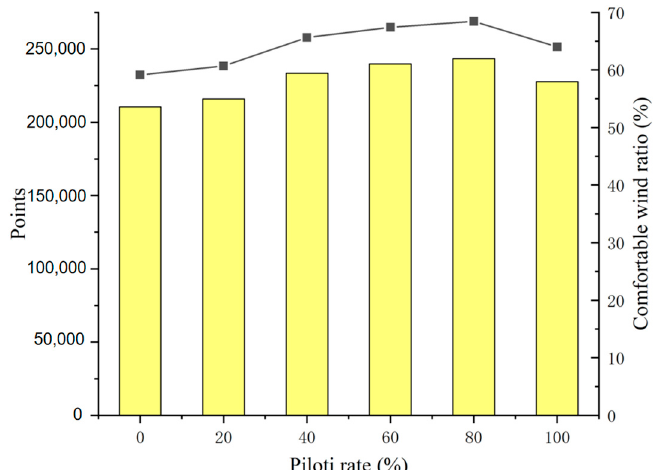
Figure 11. The changing pattern of a comfortable wind ratio under different piloti rates (Determi- Figure 11. Thechangingpatternofacomfortablewindratiounderdifferentpilotirates(Determinantmodel). nant model).